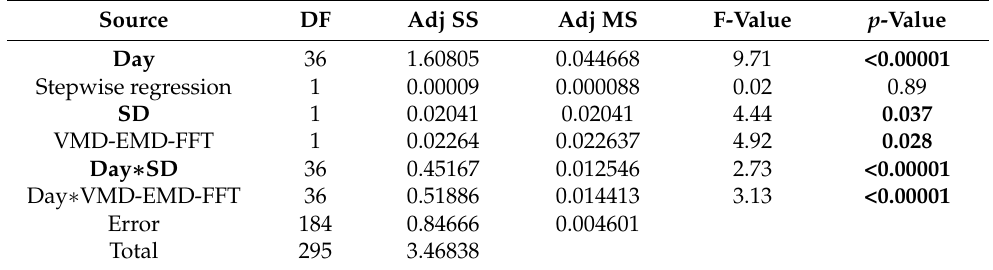
Table 9. ANOVA Table.